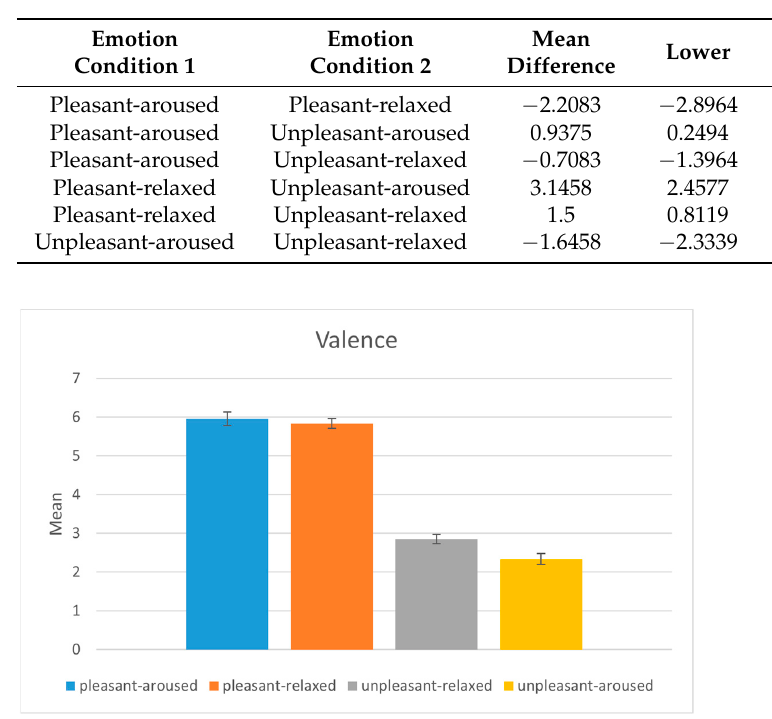
Figure 5. Analysis of the arousal values between the four emotion-eliciting conditions. Table 2. Multiple comparisons of mean arousal scores using Tukey HSD.